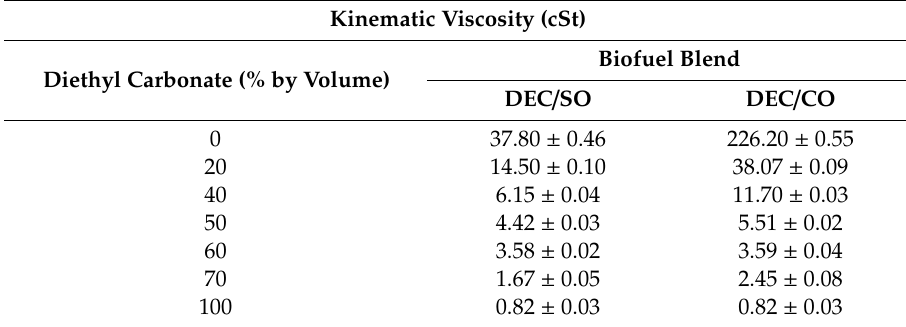
Table 3. Kinematic viscosity at 40 ◦ C in centiStokes (cSt) of diethyl carbonate (DEC) / sunflower oil (SO) and diethyl carbonate (DEC) / castor oil (CO) double blends. The error is expressed as standard deviation.